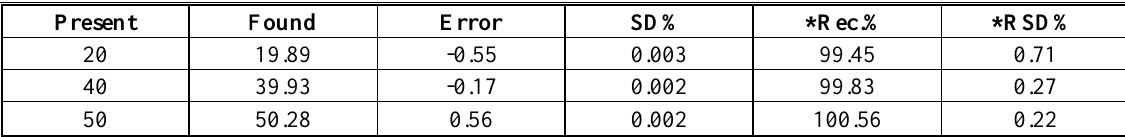
Table 3 . The precision and accuracy Present